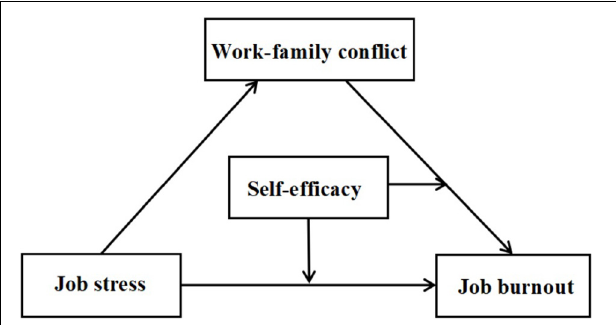
FIGURE 1 | The proposed moderated mediation